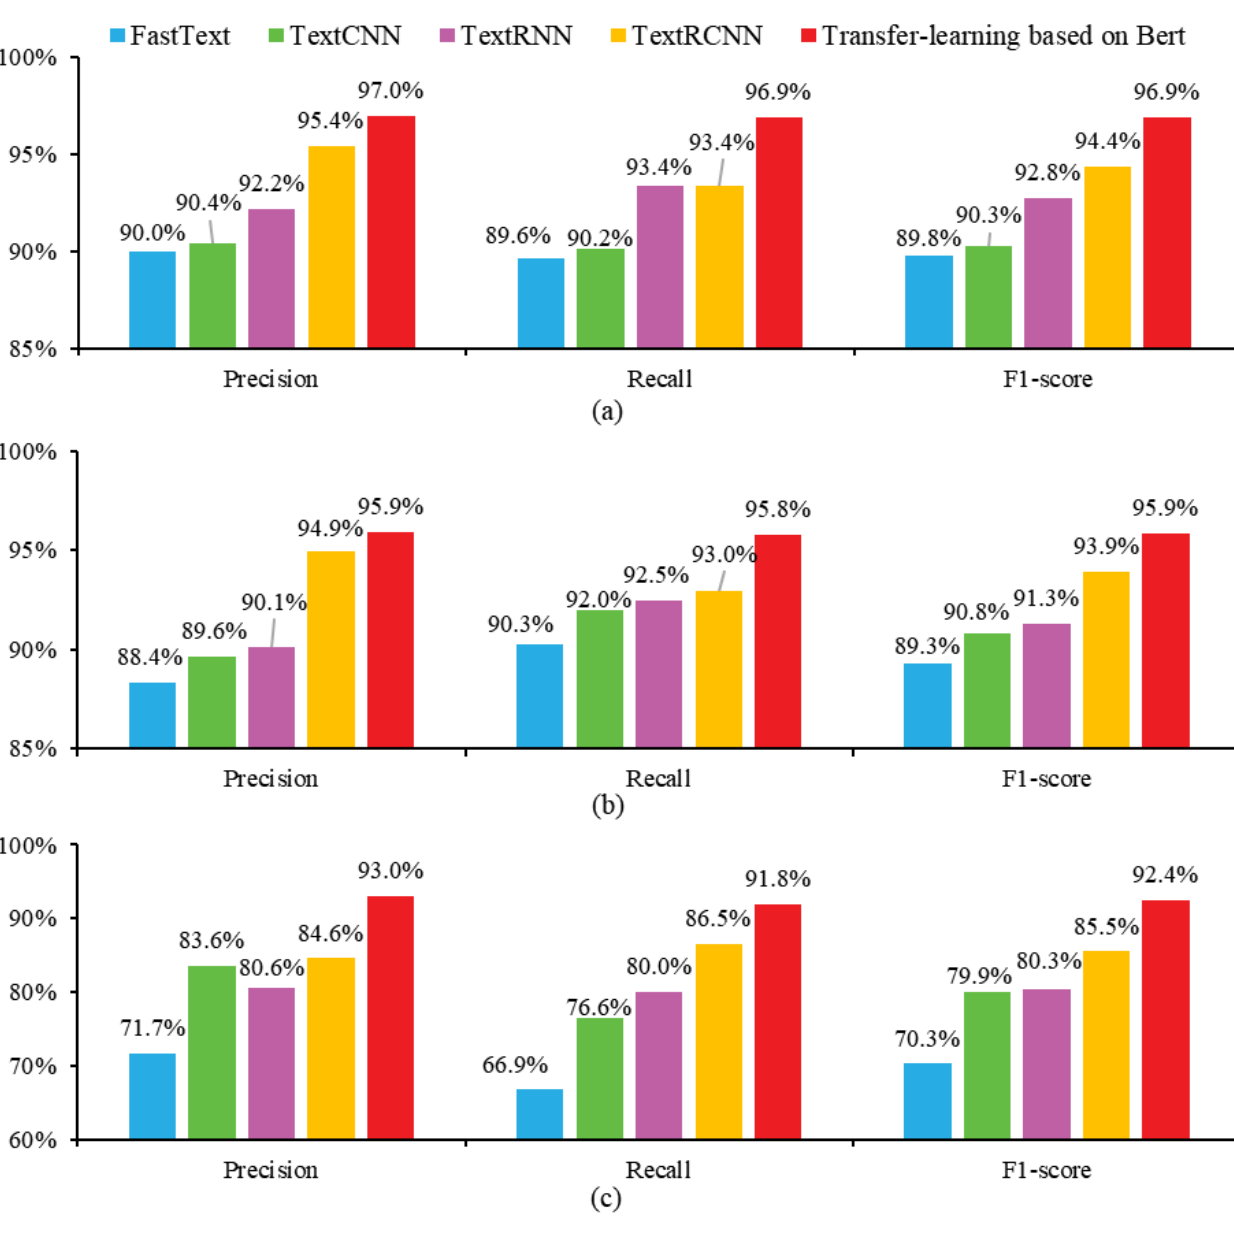
Figure 5. Precision, recall, and F1-score of ( a ) data cleansing model, ( b ) relation extraction, and ( c ) entity recognition model.